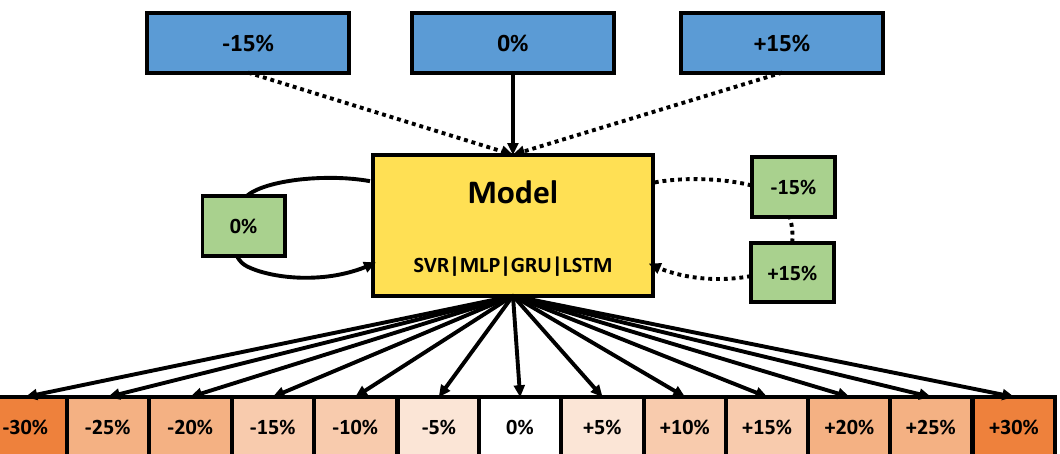
Figure 4. Illustration of the data configuration used for the sensor-specific deviation analysis. The full lines represent the original data setup for the first experiment corresponding to Section 3.2.1 in the Results section, whereas the dotted lines represent the additional datasets used for the data augmentation experiment. During the training process, the training set(s) and the validation set(s) are used to fit the different regression models. Overall, the models are then evaluated on 13 different test sets and evaluated individually for each of these sets in order to compare the performance on each sensor variation